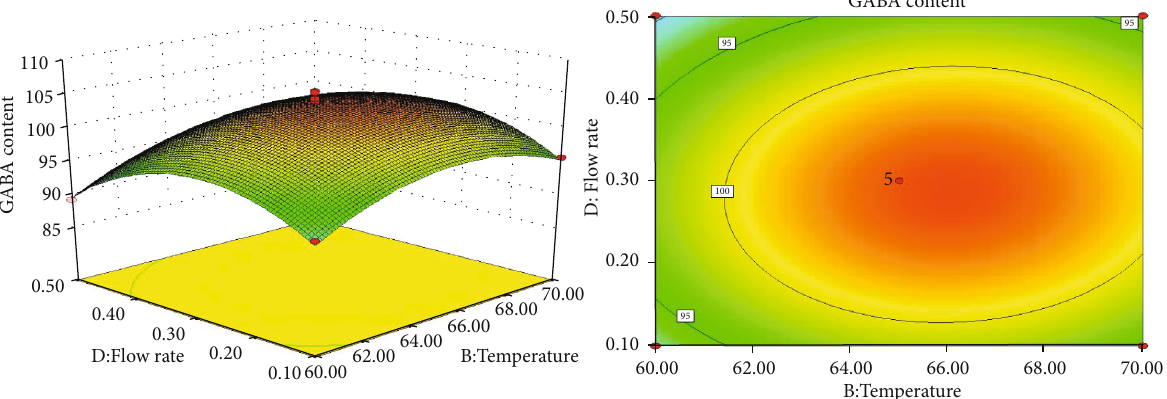
Figure 20: Response surface and contour diagram of temperature and fl ow rate in fl uence on GABA